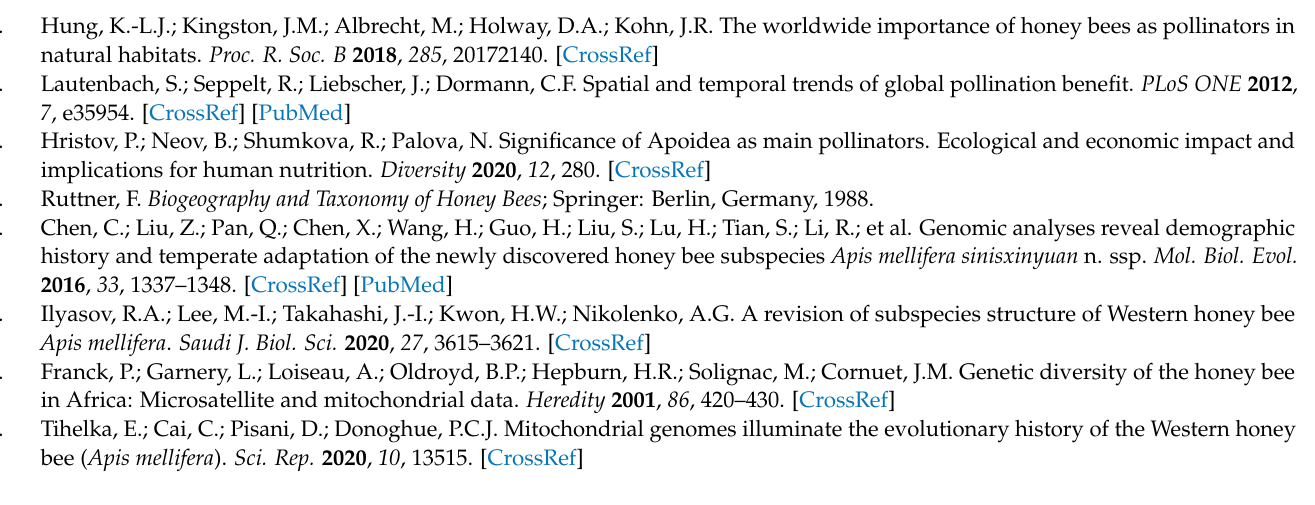
Lima, Piura, and Jun í